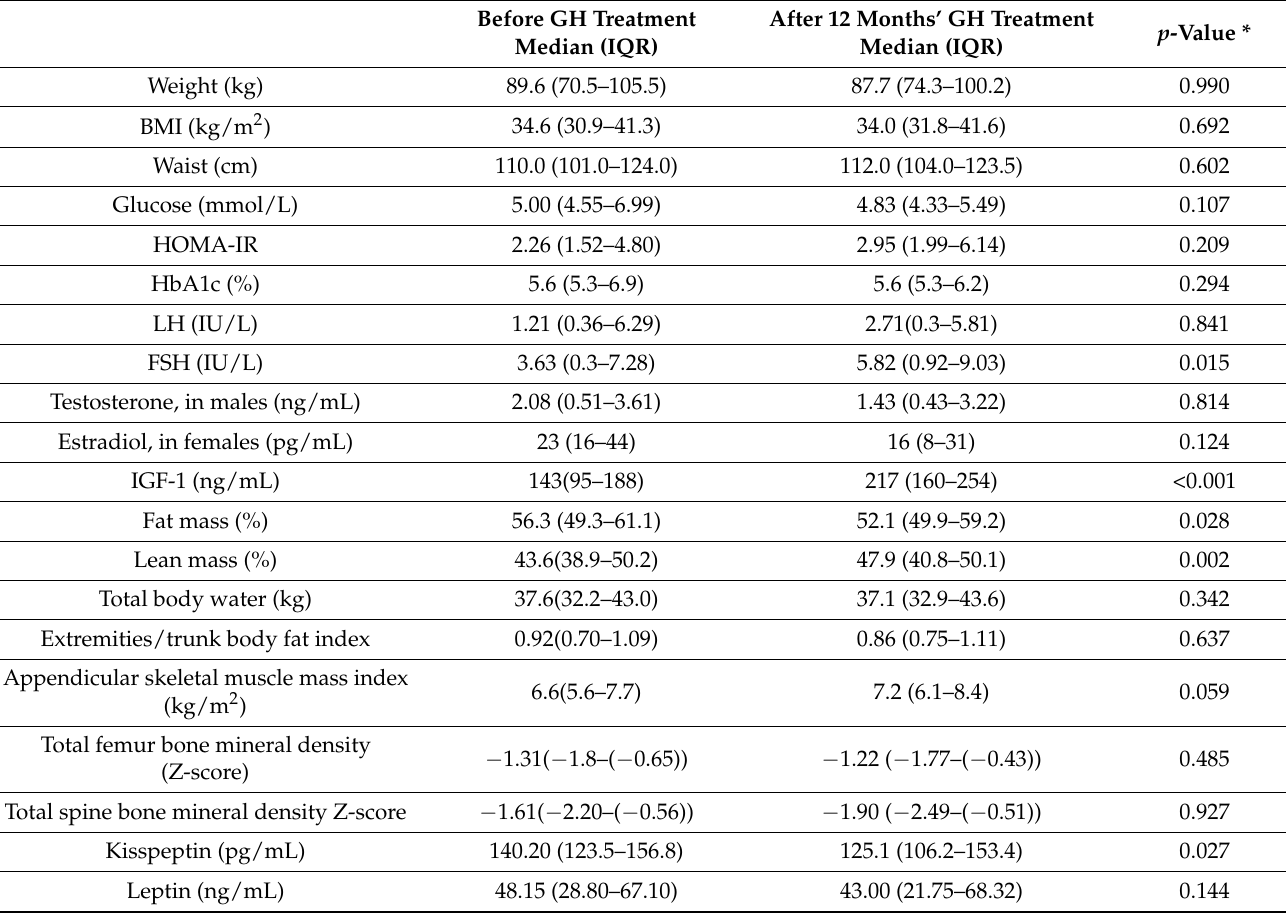
Table 2. Anthropometrics, body composition, and plasma hormone levels in patients with PWS before and after 12 months’ growth hormone treatment.